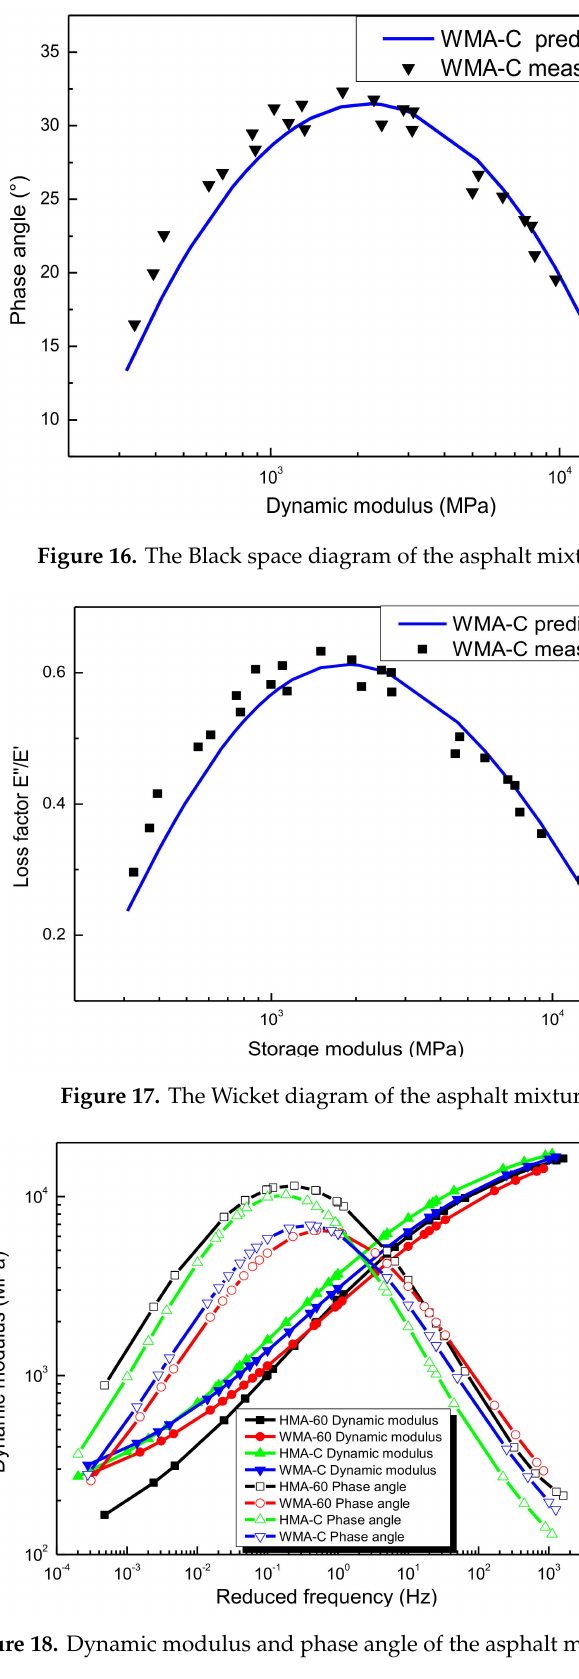
Figure 18. Dynamic modulus and phase angle of the asphalt mixtures